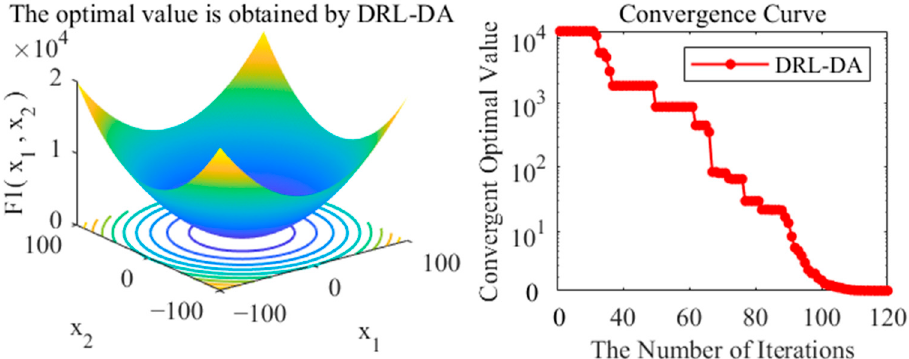
Figure 21. Solving method with DRLDA algorithms.